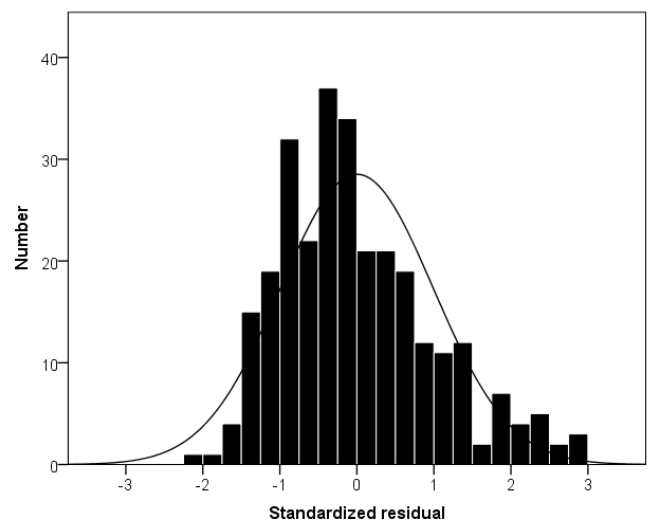
Figure 9. The distribution of the standardized residual data (mean = 0, standard deviation = 0.994, N = 284).